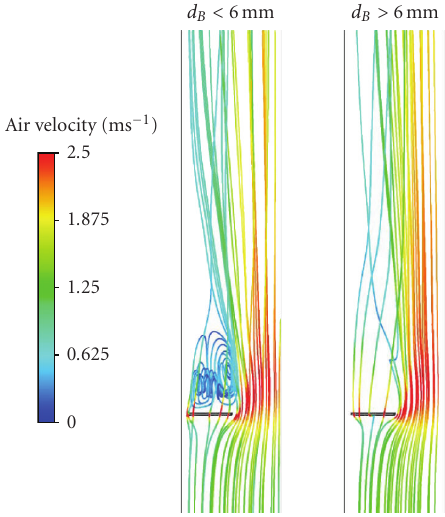
Figure 12: Streamlines for small (left) and large (right) bubbles (run 096) (CFX).